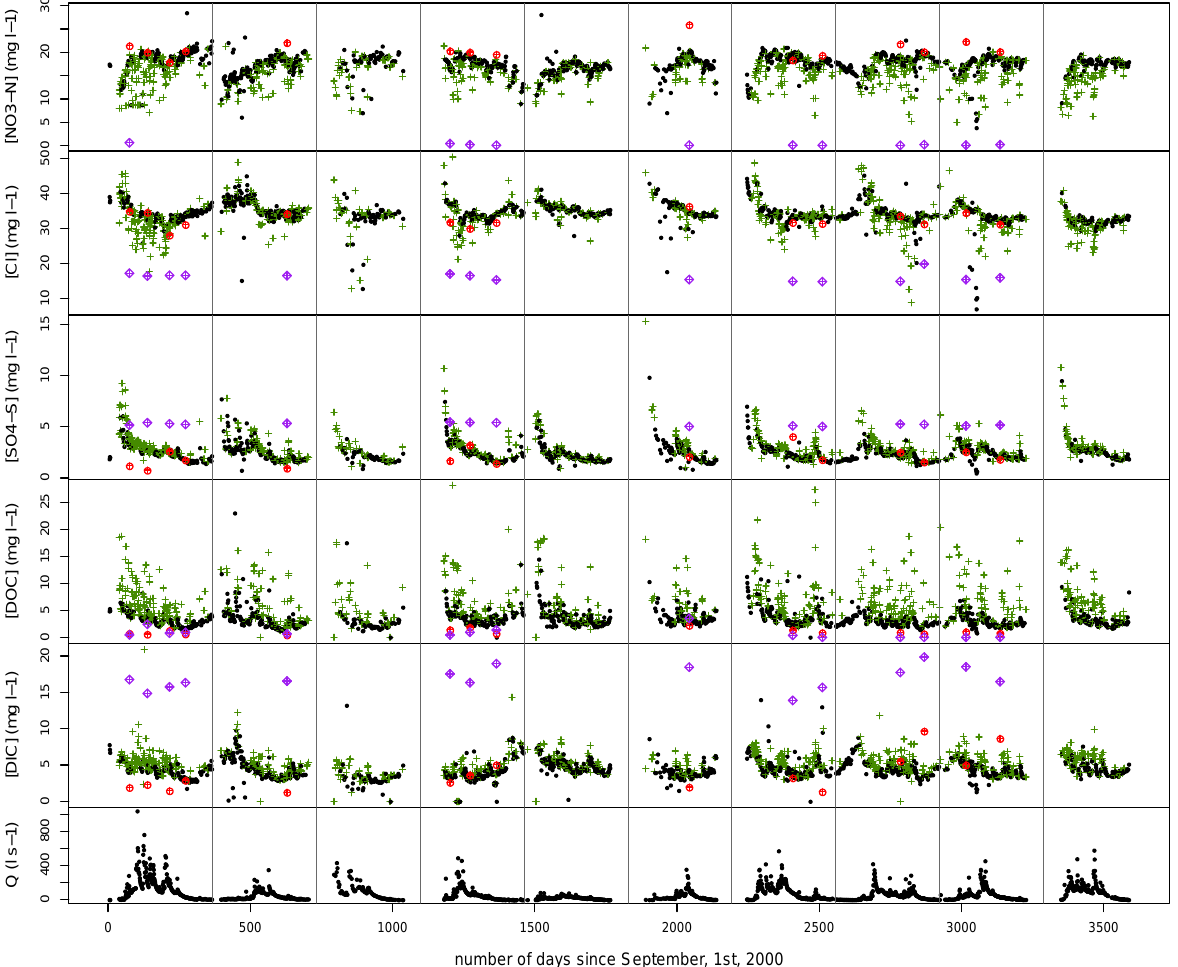
Fig. 2. Time series of daily stream concentrations and quarterly groundwater (GW) concentrations of nitrate, chloride, sulphate, dissolved organic carbon (DOC), and dissolved inorganic carbon (DIC) from September 2000 to August 2010. Vertical lines represent the start of each hydrological year. Interflood concentration is plotted in black dots, while flood concentration is plotted in green crosses. Daily discharge (Ls − 1 ) is shown in the last line. Purple diamonds represent deep downslope GW and red circles represent upland GW. For interpretation of the references to colour in this figure legend, the reader is referred to the web version of this